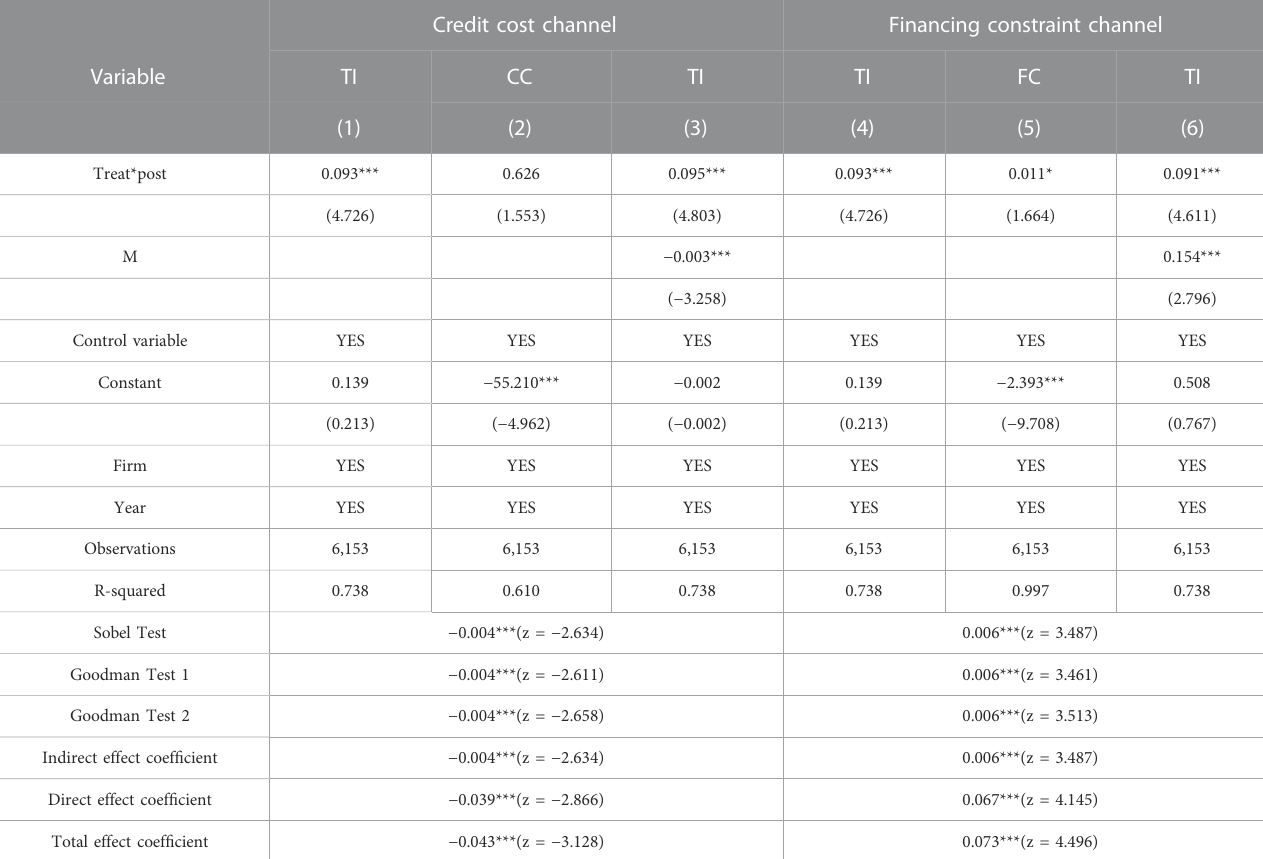
TABLE 7 Test results of intermediary effect based on credit cost and fi nancing